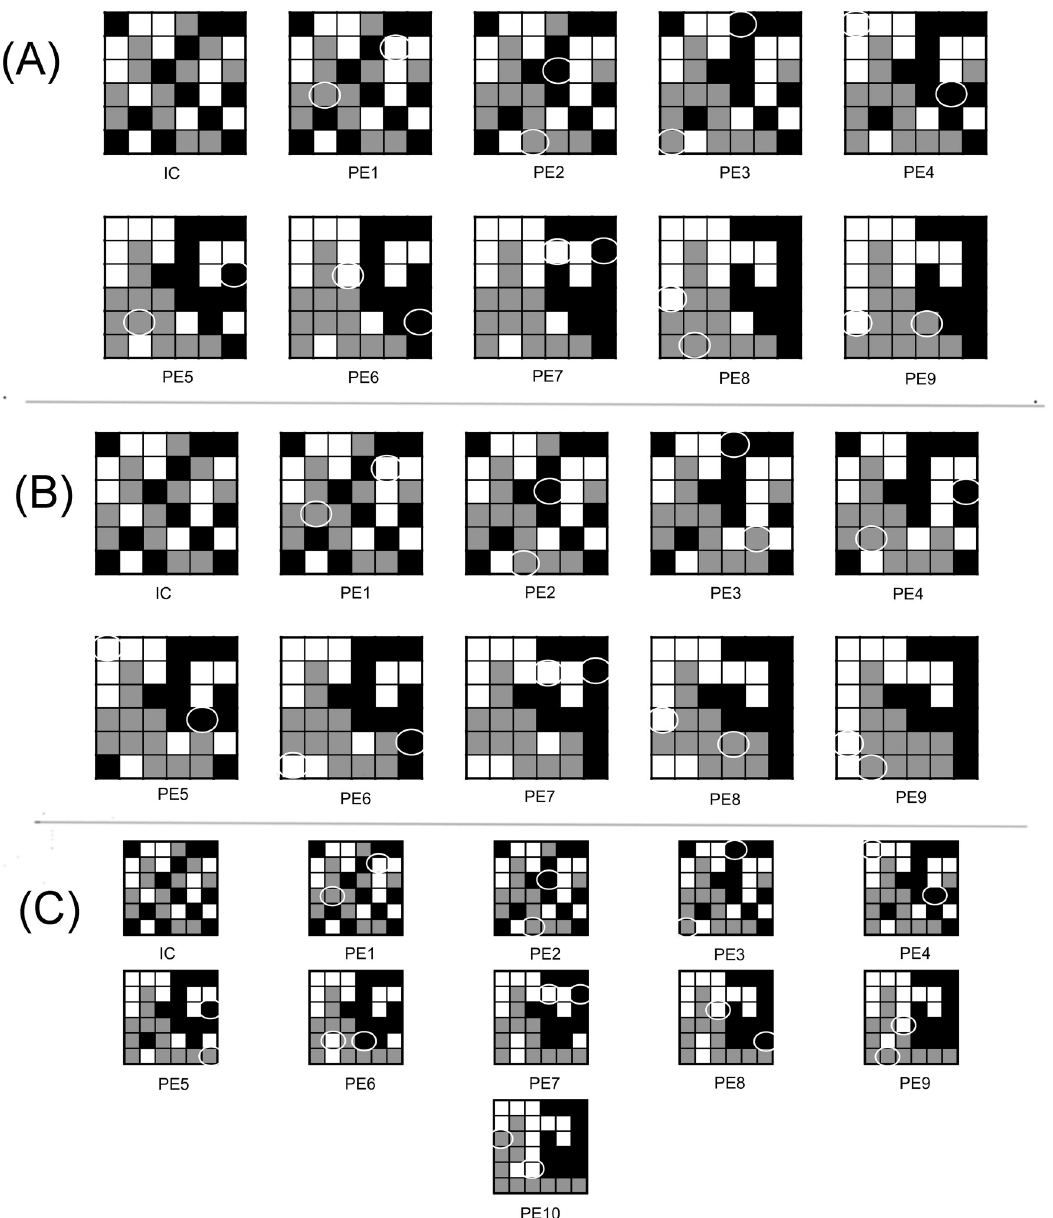
Fig 6. Dominant minimal paths and other locally optimal paths that minimally deviate from dominant minimal paths associated with the initial landscape shown in Fig 4A. (A) One of 40 dominant minimal paths (corresponds to locally optimal landscape shown in Fig 4B). The circles indicate parcels that were exchanged from the previous step. (B) One of 12 locally optimal paths that minimally deviated from a dominant minimal path (corresponds to locally optimal landscape shown in Fig 4J). The minimal deviation in this case is that the locally optimal path is a minimal path that is not increasing, and this can be observed in Fig 8A (dotted). (C) A second locally optimal path that is not a dominant minimal path (corresponds to locally optimal landscape shown in Fig 4K). 10 parcel exchanges were required to reach a locally optimal landscape, compared to the 9 parcel exchanges required in the paths shown in (A) and (B). The parcel exchange maps provide a rearrangement schedule, and allow decision-makers to visualize how the rearrangement process may unfold in